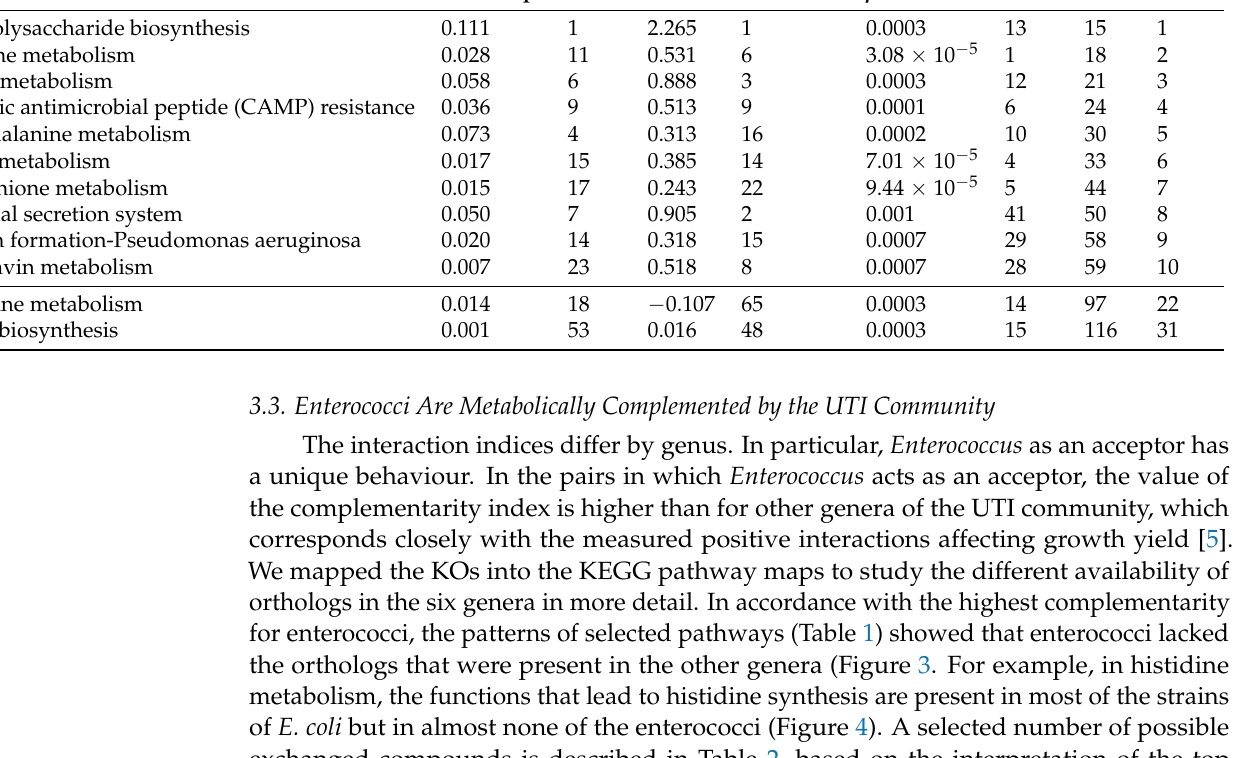
Table 1. Pathways with high complementarity for the pairs with increased growth yield. Top ranking pathways according to the RF feature importance, the SVM coefficients, the MWU p -values, and the ensemble of the previous ranks. Pathways RF SVM MWU Ensemble Feat. Imp. Rank